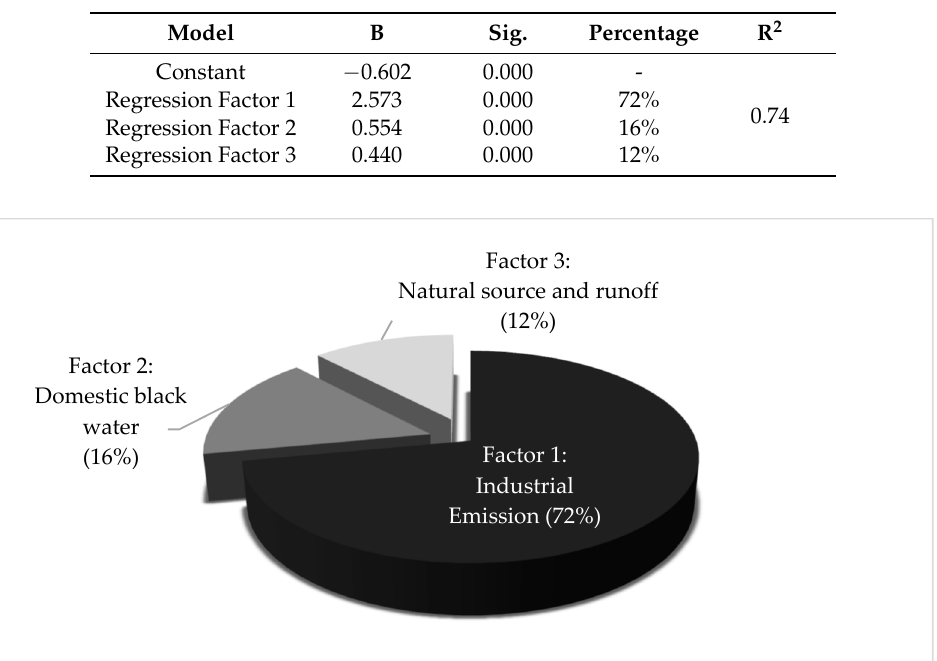
Table 6. Contribution percentage of each factor from MLR results.